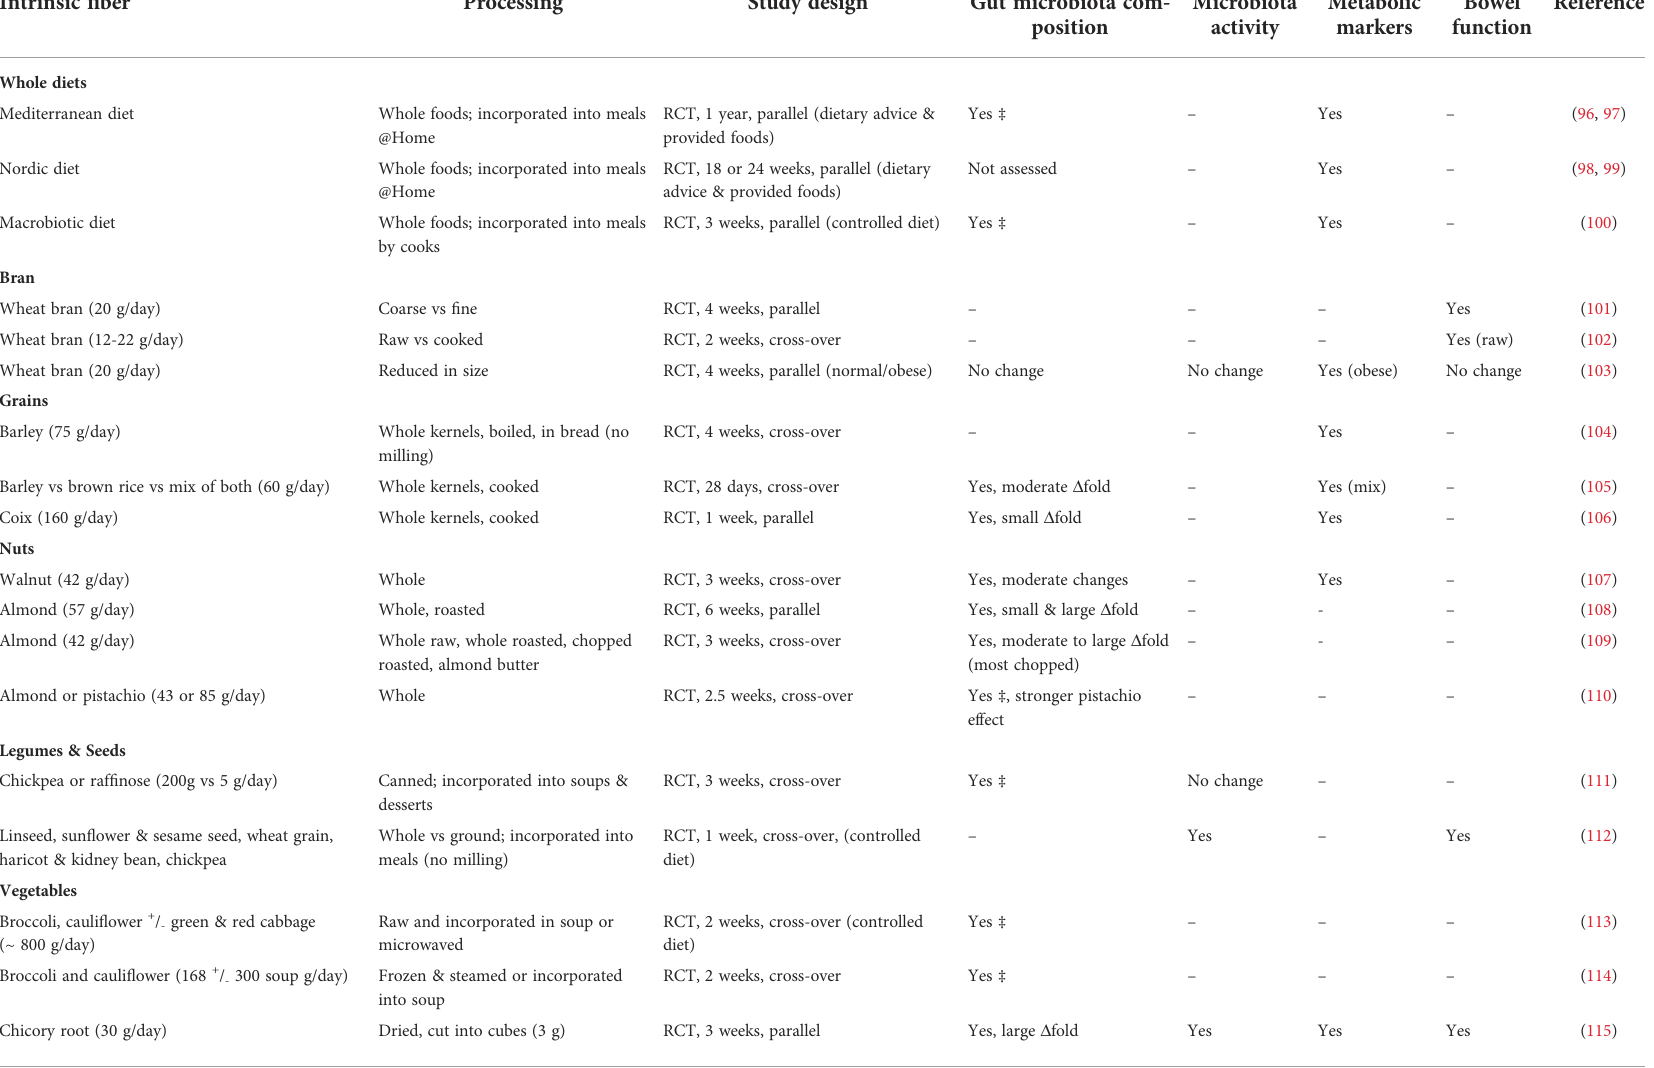
TABLE 1 Human intrinsic fi ber